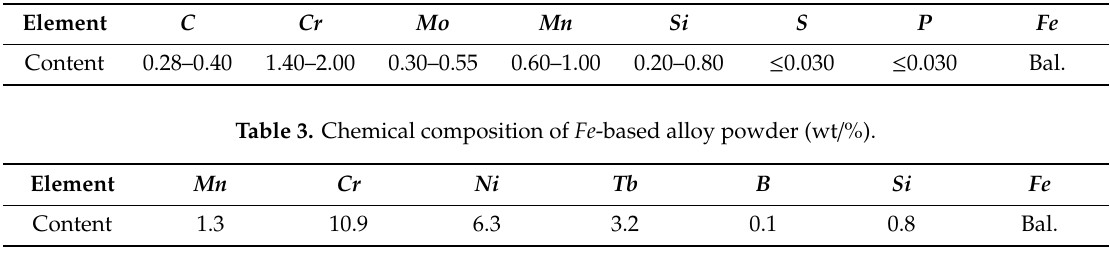
Figure 8. The morphology of the mould: ( a ) before laser cladding, ( b ) after laser cladding and ( c ) after penetrant flaw detection. Table 2. The chemical composition of the P20 steel (wt / %).